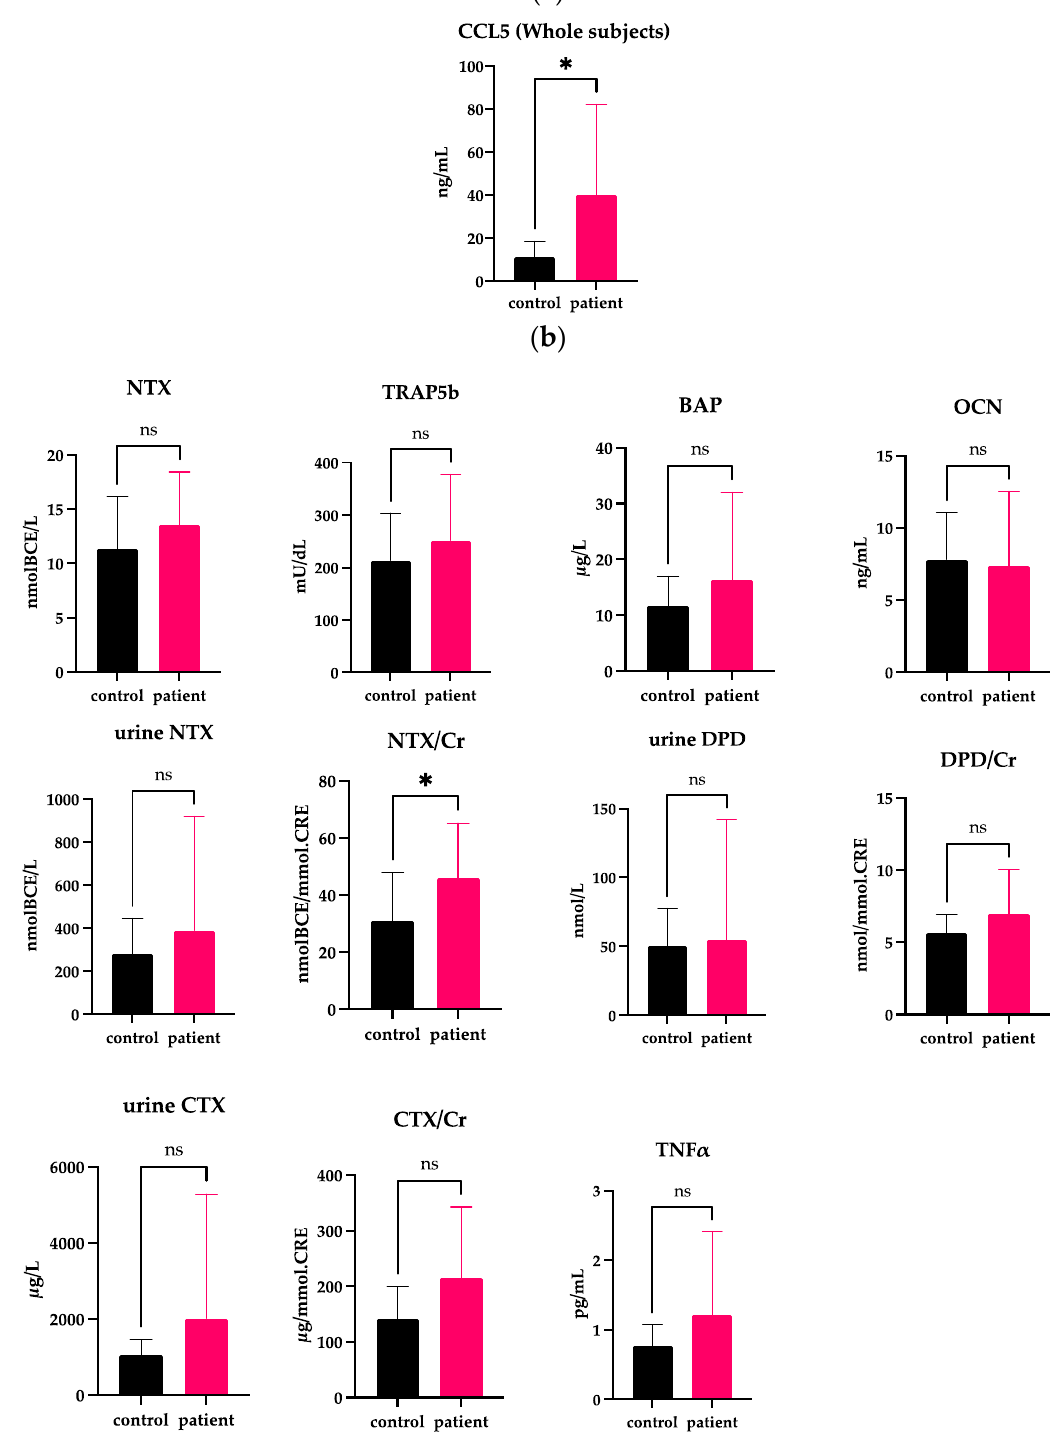
Figure 1. Measurement of CCL5 and other markers related to bone metabolism and inflammation in the serum or urine obtained from all subjects. ( a ) Serum CCL5 levels are significantly higher in the group of all DJD-TMJ subjects (n = 17) than in control groups (n = 17). ( b ) Serum or urine markers related to bone metabolism and inflammation were compared between the control group (n = 17) and the group of all DJD-TMJ subjects (n = 17). t -test, two-tailed. * Indicates a significant difference at p < 0.05. Table 1. List of laboratory results for all DJD-TMJ and control subjects. Highlighted in yellow shows patients with systemic diseases.